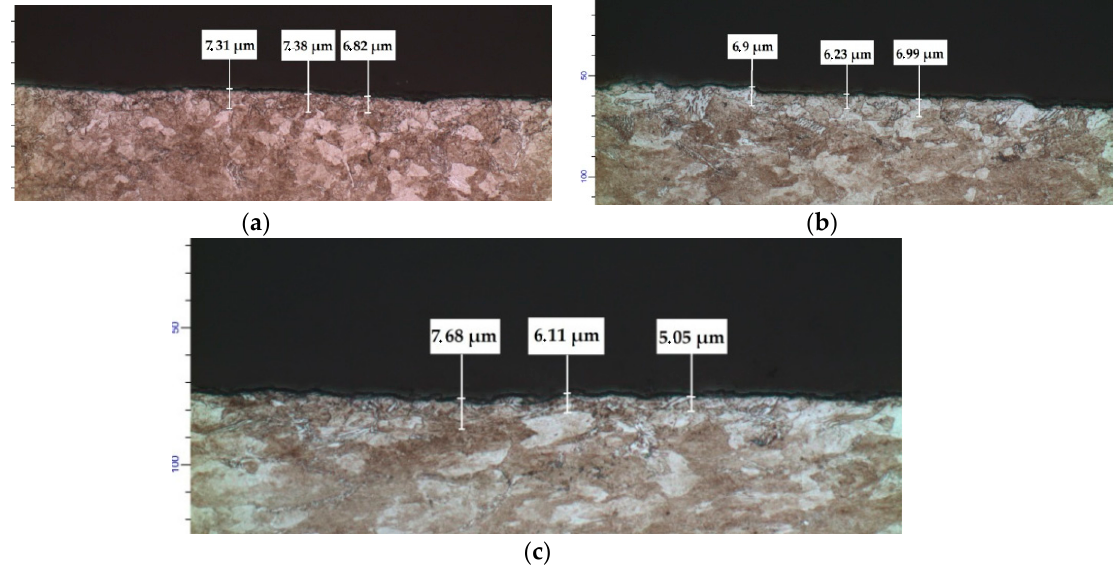
Figure 4. Thickness of fine grain layers after each pass of the multipass drawing process through α = 5° dies: ( a ) the first pass, ( b ) the second pass, ( c ) the third pass.